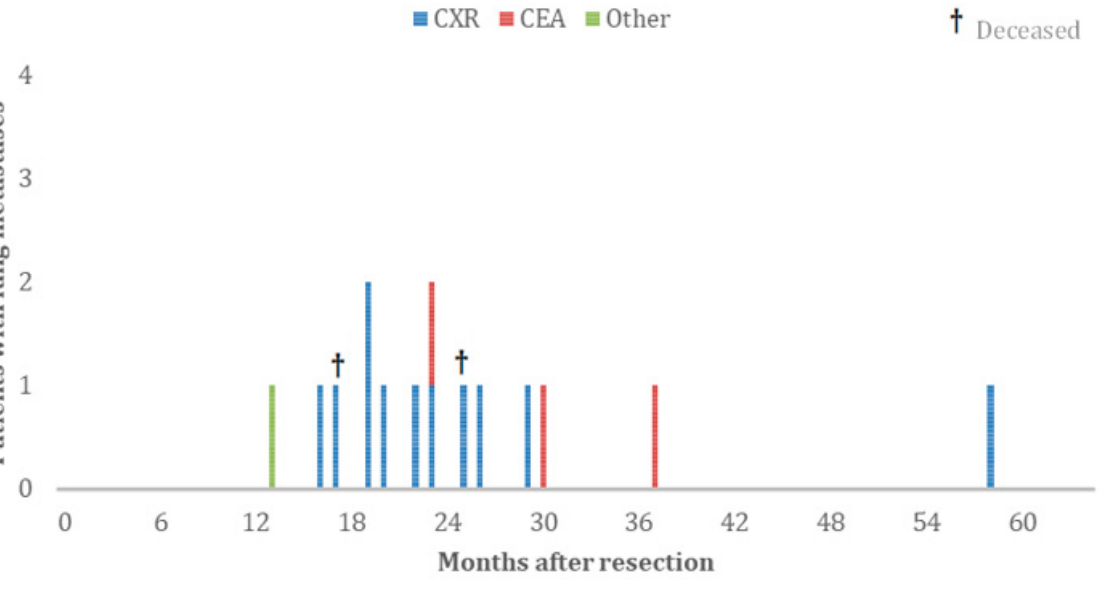
Figure 3. Patients with pulmonary metastases treated with curative intent, categorised by abnormal surveillance test.